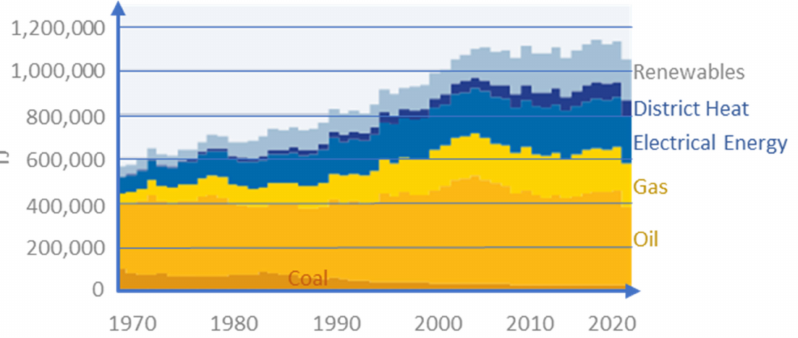
Figure 3. Development of the used energy mix in Austria 1970–2020 (adapted from [59] with permission from E-Control 2021).